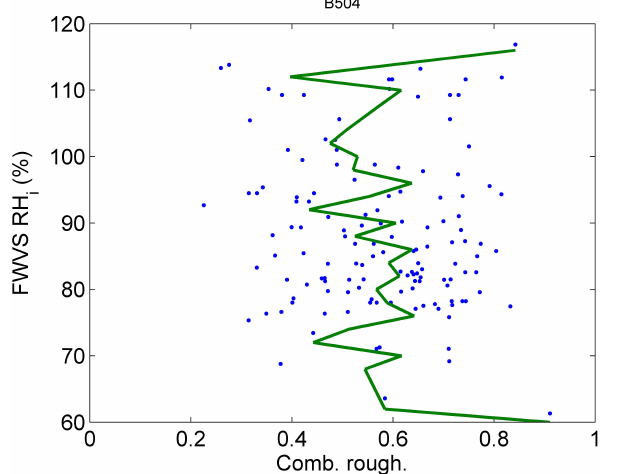
Fig. 9. Halo ratio plotted against particle roughness measure RMD/SD, both determined from SID-3 patterns obtained in cirrus formed in marine air masses. Mean halo ratio calculated for fixed roughness intervals, and a least-squares regression line (coefficients given in the legend) are also shown. The correlation coefficient was − 0.22, significant at the 0.1% level, based on 239 data